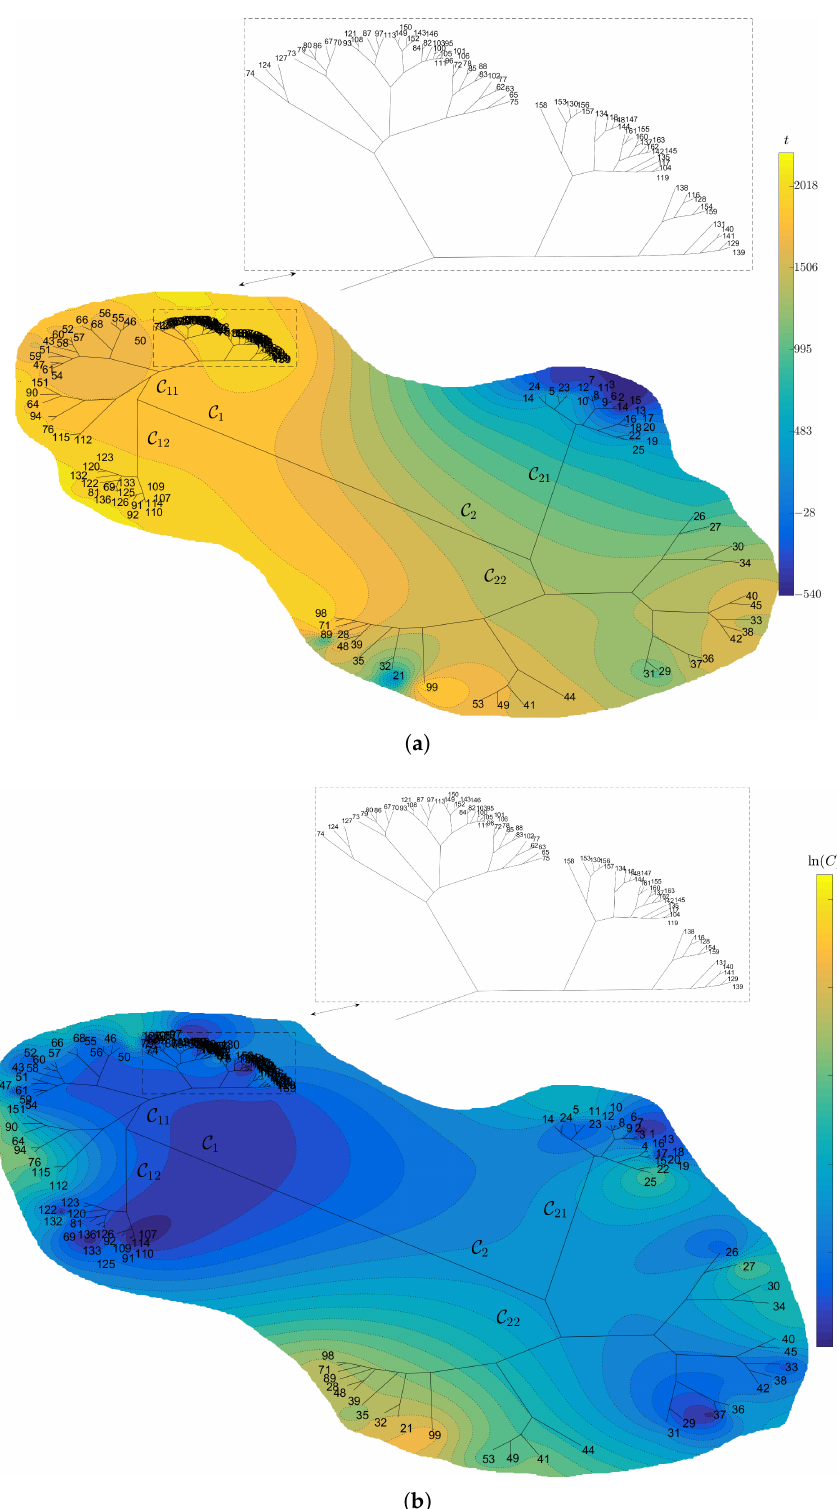
Figure 2. The hierarchical trees obtained with the Sørenson distance, d 9 , and the 3rd dimension calculated by RBI based on: ( a ) time (year), t ; ( b ) logarithm of the casualties, that is, ln ( C ) . A magnification of the denser part is